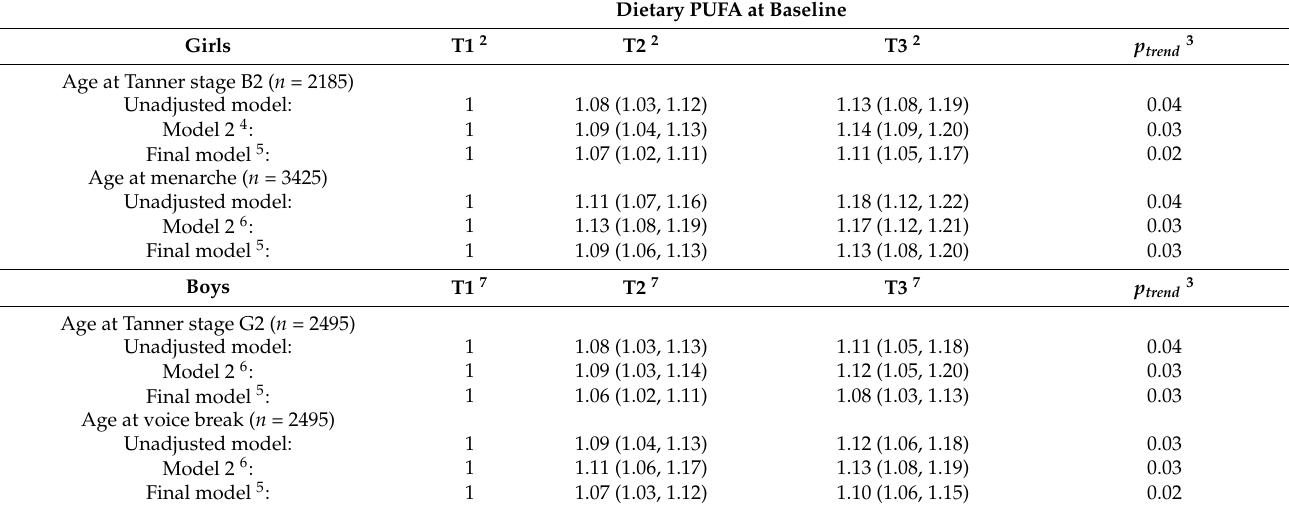
Table 3. Association 1 of dietary polyunsaturated fatty acid (PUFA) in childhood with puberty timing. Dietary PUFA at